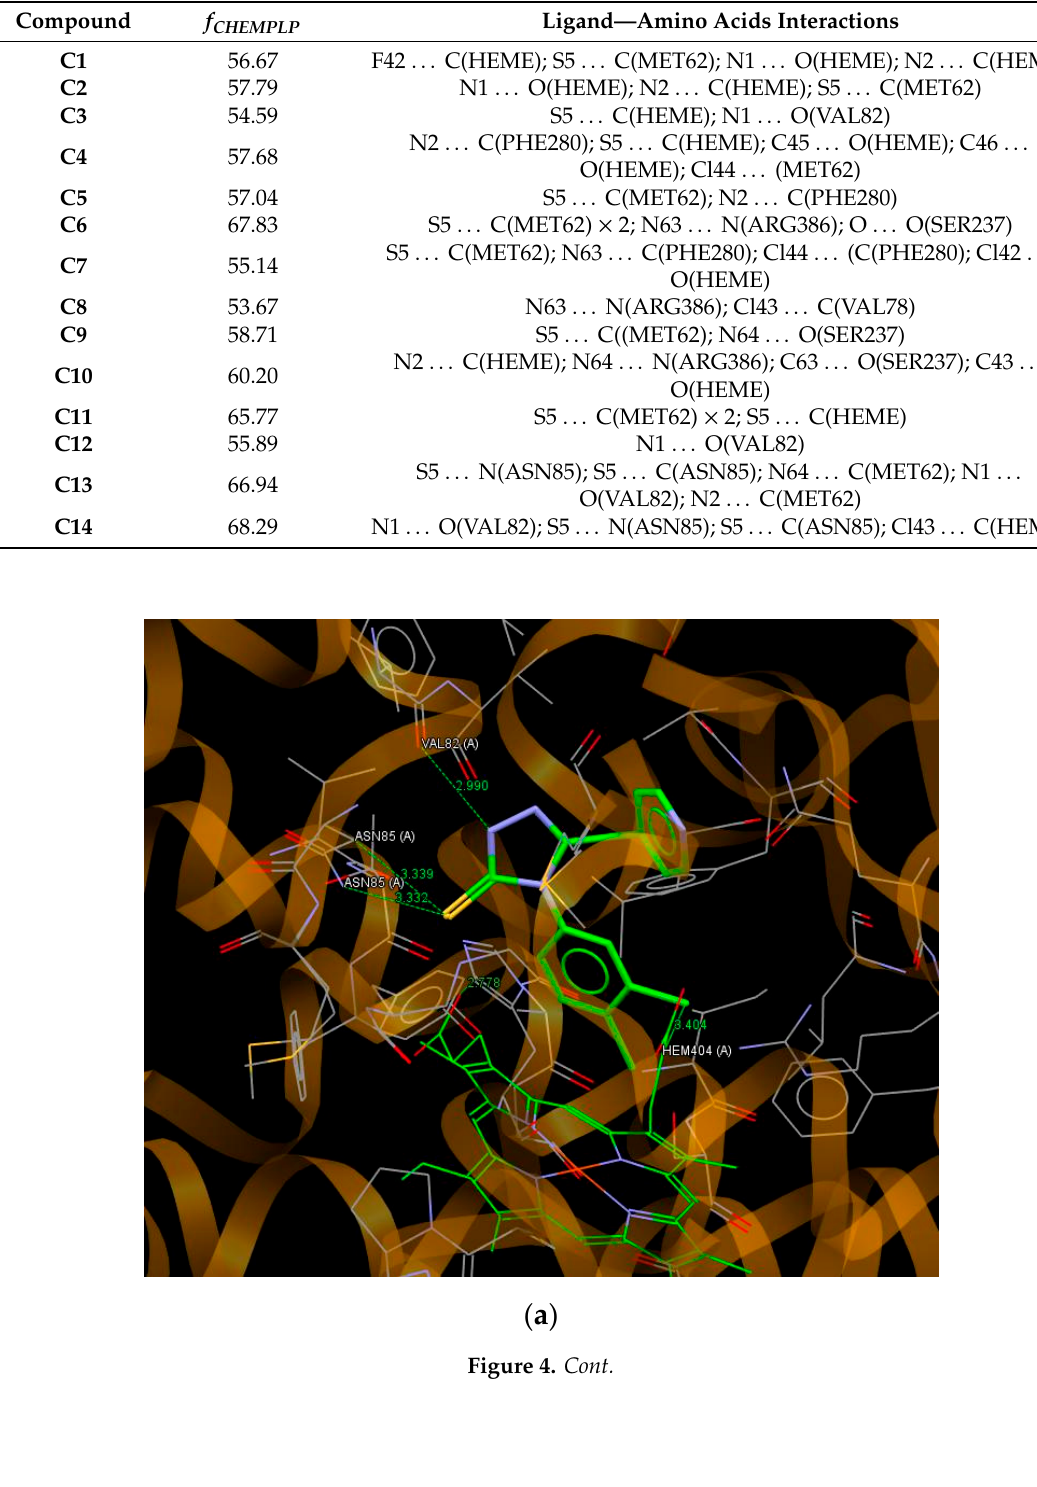
Table 5. The results of the molecular docking of ligands C1 – C14 to the P450 CYP121.